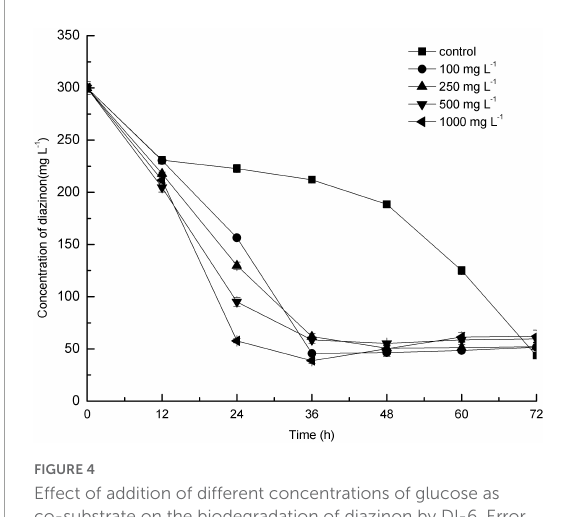
FIGURE4 Effect of addition of different concentrations of glucose as co-substrate on the biodegradation of diazinon by DI-6. Error bars, mean ± SD of three replicates. Each symbol represents the concentration of added glucose, Square: control indicates no added glucose; Circle: 100 mg L − 1 of glucose was added; Upper triangle: 250 mg L − 1 of glucose was added; Lower triangle: 500 mg L − 1 of glucose was added; Left triangle: 1000 mg L − 1 of glucose was